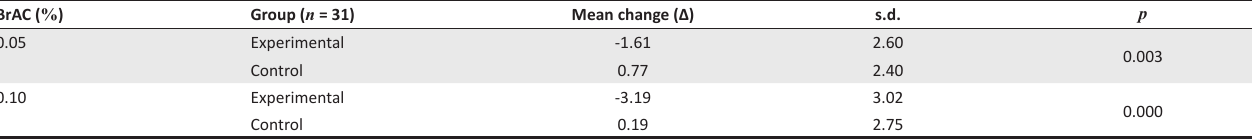
TABLE 5: Mean change for negative fusional vergence at distance for blood respiratory alcohol concentration levels of 0.05 % and 0.10 % . BrAC ( % ) Group ( n = 31) Mean change (∆) 0.05 Experimental 0.10 Experimental